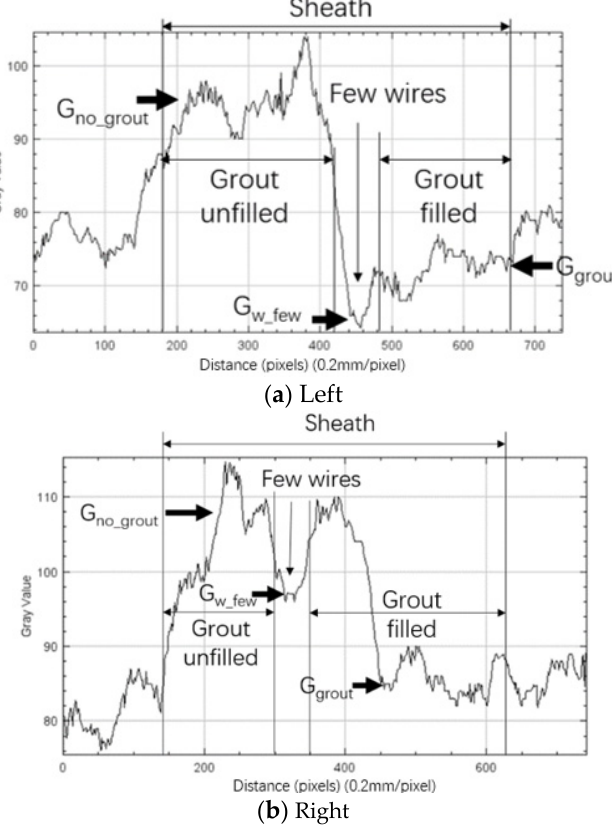
Figure 33. Gray value profiles of Figure 32. ( a ) Left; ( b ) Right. Table 5. Gray value numbers and K ratios of Figure 33. 750 mm by 3.95 MeV, grout is not filled. Location